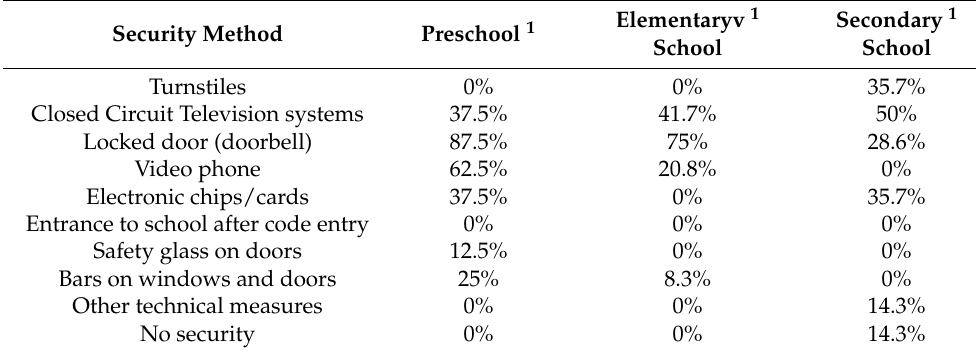
Table 4. Technical security of schools—percentage of